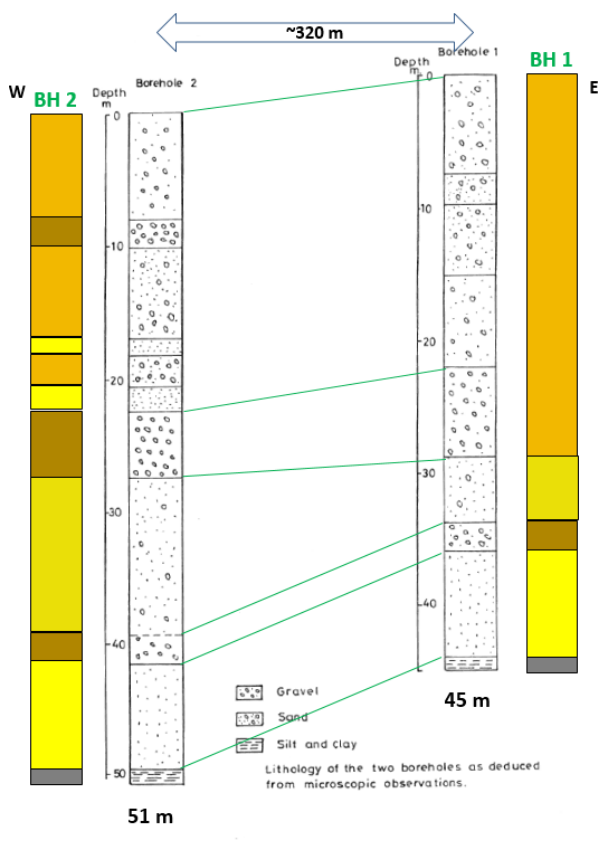
Figure 2. Lithologic columns of the boreholes BH1 and BH2 from microscopic analyses, referenced to their surface elevation (black and white columns are the original columns of El-Isa et al., 1995). The coloured, generalized columns are used for the figures of this paper. The main dip tendencies of the units toward the west are vis- ible by the green connecting lines. The annotated borehole depths below the columns follow the text in El-Isa et al.